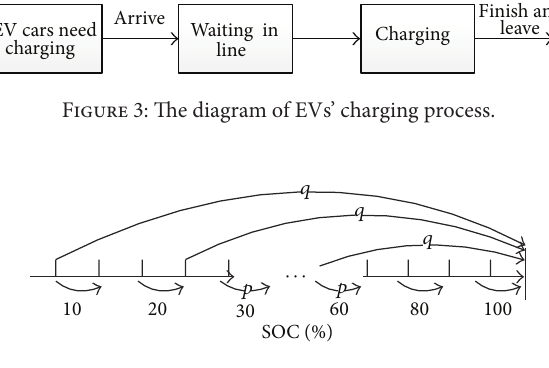
Figure 4: The diagram of charging state